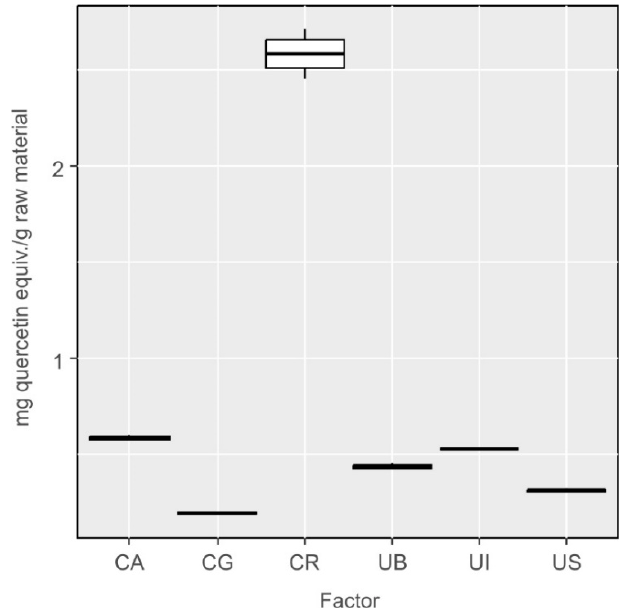
Figure 9. Results of determination of the content of flavonoids in extracts from Cladophora and Ulva species using the complexometric with Al 3+ ions method, converted into milligram equivalents of quercetin per gram of raw material.